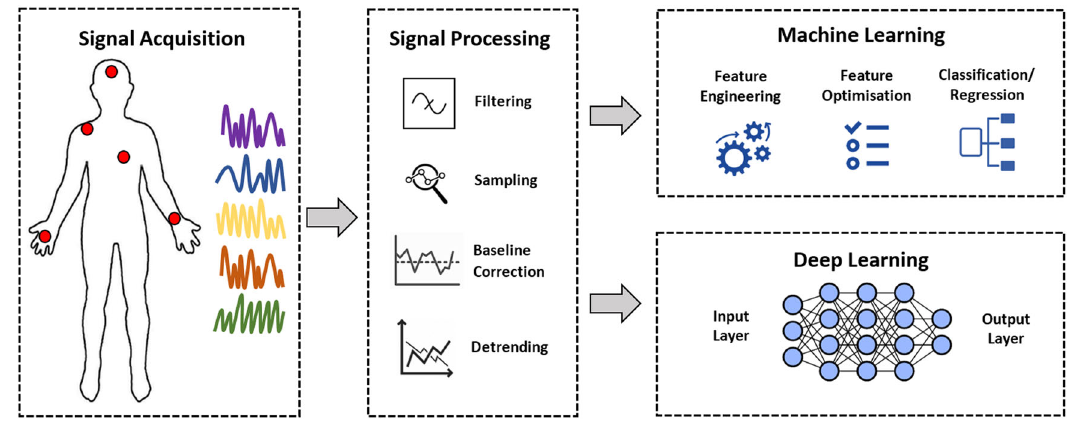
Fig. 3 Data analysis pipeline of machine learning and deep learning models. After signal acquisition, the fi rst stage in the data analysis pipeline is signal processing, followed by either the classical machine learning or deep learning